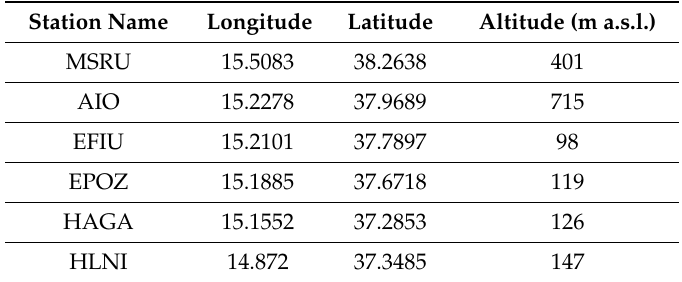
Figure 1. Map of a portion of the Mediterranean Sea, showing bathymetry (data from http://marine.copernicus.eu/) and the location of the six seismic stations used in this work (black dots and labels). The inset in the right upper corner shows the digital elevation model of Eastern Sicily, with the location of the seismic stations. Table 1. Coordinates of the seismic stations used in this work.